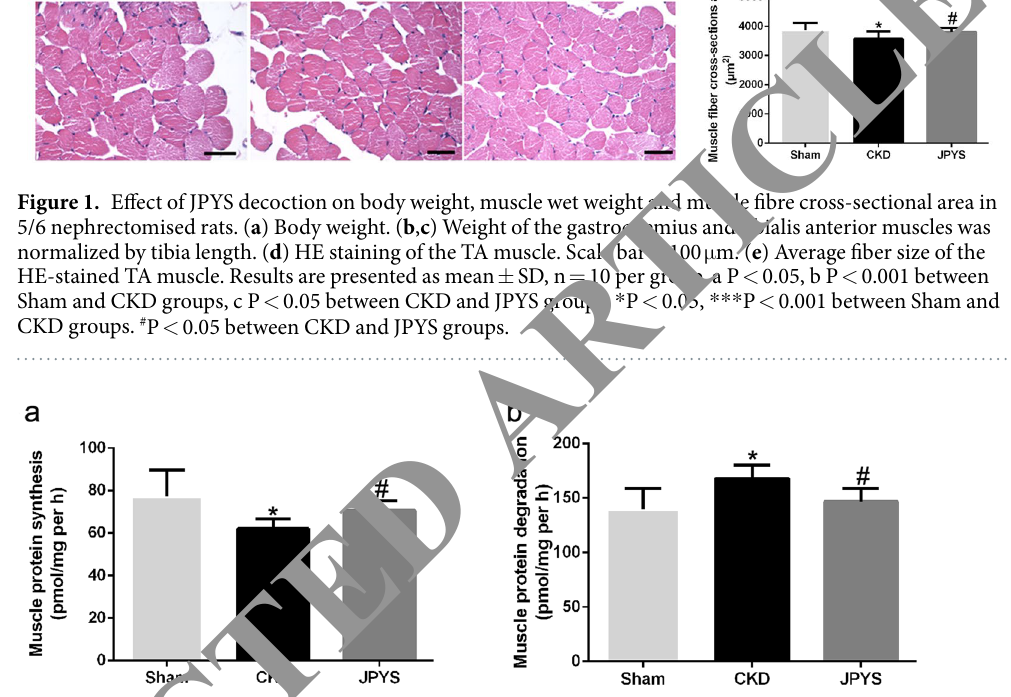
Figure 2. Effect of JPYS decoction on muscle protein synthesis and protein degradation in 5/6 nephrectomised rats. ( a ) Protein synthesis was measured from the rate of incorporation of L-[U- 14 C] phenylalanine into isolated, incubated soleus muscles. ( b ) Protein degradation was measured as the rate of tyrosine released from isolated soleus muscles. Results are presented as mean ± SD, n = 6 per group, * P < 0.05 between Sham and CKD groups. # P < 0.05 between CKD and JPYS